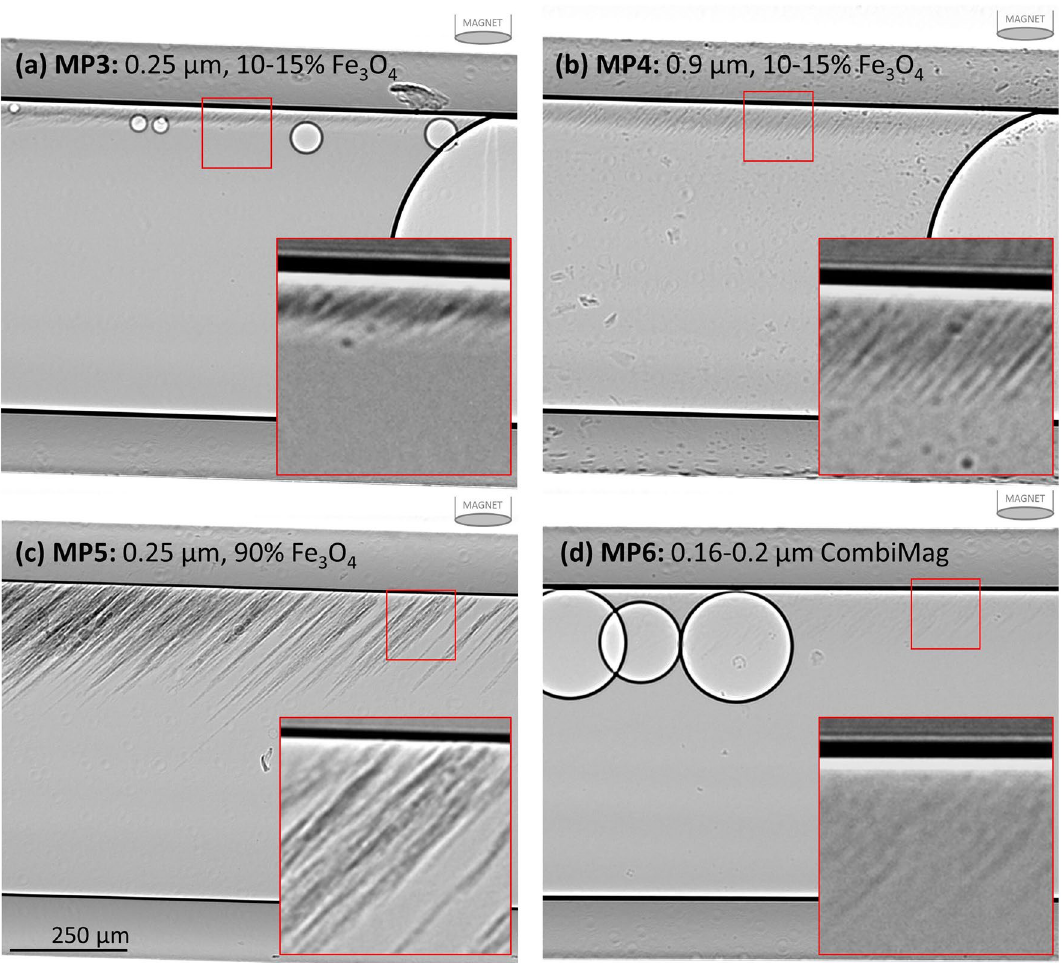
Figure 6. As the magnet was translated to the right above the capillary tube, the angle of the MP strings changed. ( a ) MP3, ( b ) MP4, ( c ) MP5 and ( d ) MP6. Red boxes contain a contrast-enhanced enlargement. Note that the supplementary videos are informative as they reveal important particle structure and dynamic information that cannot be visualised in these static